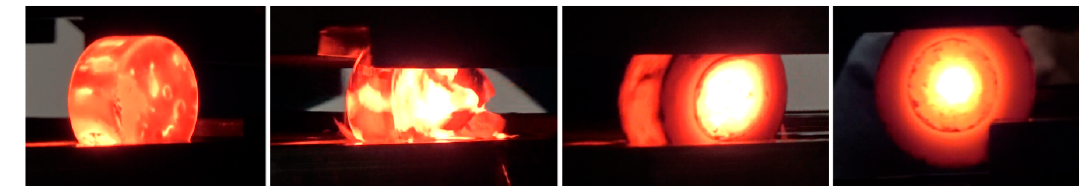
Figure 9. Process of the rotational compression in a channel (path s = 700 mm) of a sample heated to 1150 °C, where (respectively from the left): Sample location; gripping the sample by the movable jaw and flaking of a scale; rotational compression of the sample; ejecting the sample from the working area of the tools.